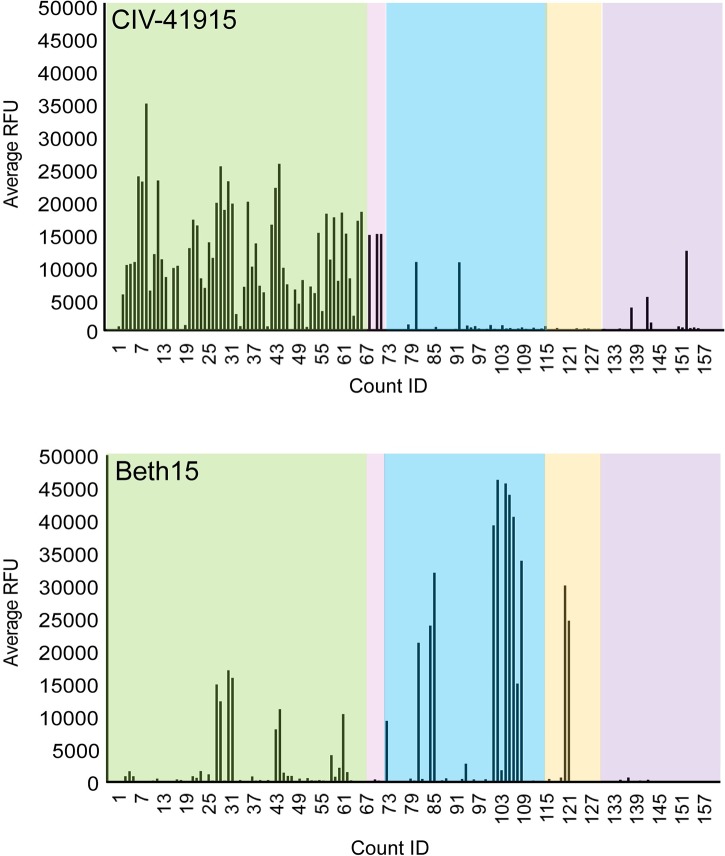
Glycan array binding.Fluorescently labeled CIV-41915 and Beth15 viruses were incubated on the glycan microarray for 1 hour at 4°C, to inhibit viral neuraminidase activity, then the slide was washed to remove unbound virus and scanned using a ProScanArray microarray scanner for Alexa Fluor 488 fluorescence and results shown as RFU. Each bar represents a single glycan. Green box = α2,3; pink box = α2,3 + α2,6; blue box = α2,6; orange box = α2,8; and purple box = miscellaneous + NeuGc glycans.